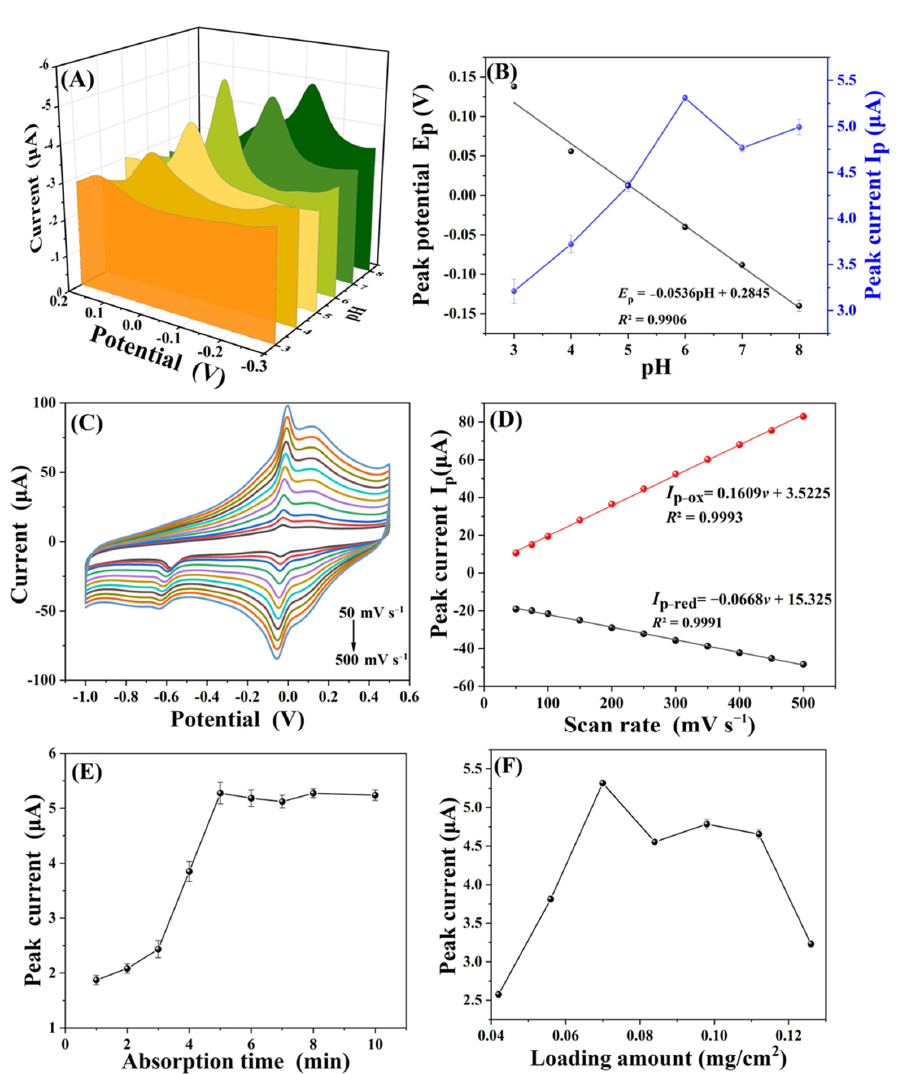
Figure 3. ( A ) DPVs of 360 µ M FT in different pH; ( B ) Variation of peak potential and current of 360 µ M FT with pH; ( C ) CVs of NH 2 -MIL-125(Ti)/RGO/GCE in PBS containing 360 µ M of FT at different scan rates: (50, 75, 100, 150, 200, 250, 300, 350, 400, 450, and 500 mV/s); ( D ) Linear relationship between the peak current and scan rate; ( E ) Effect of absorption time of FT solution (360 µ M) on the reduction peak current; ( F ) Effect of loading amount of NH 2 -MIL-125(Ti)/RGO on the reduction peak current of 360 μ M FT.